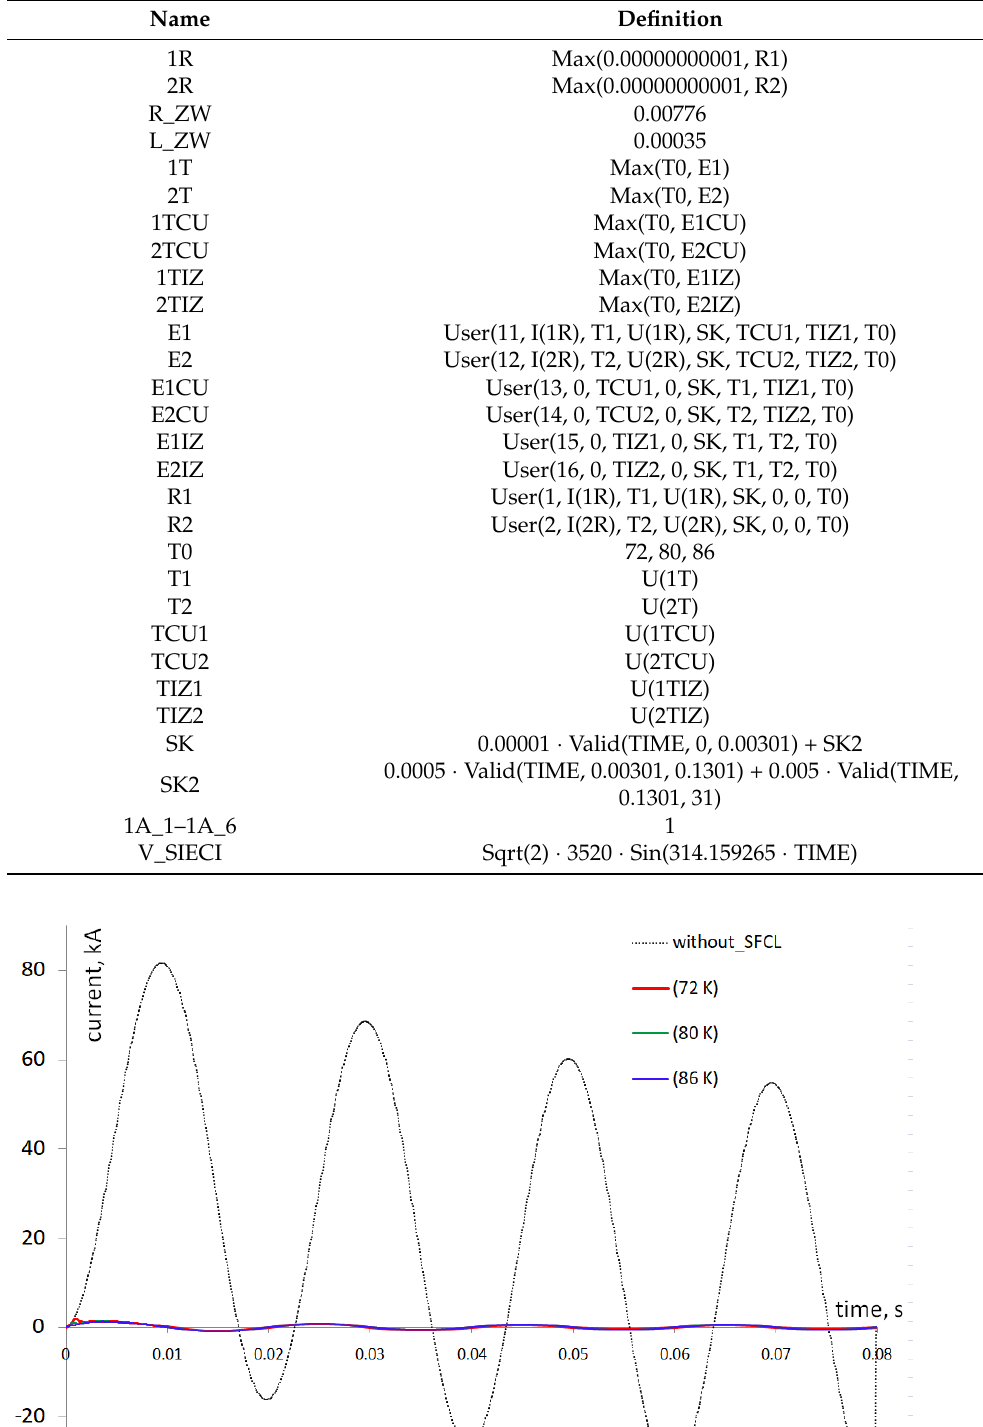
Table 3. Parameters of numerical model.